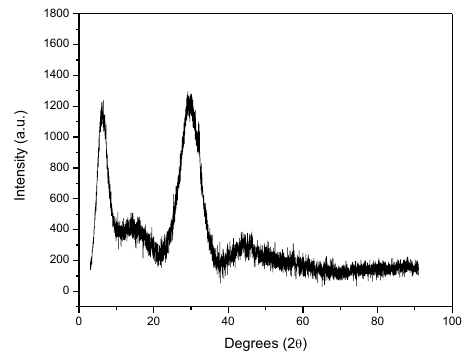
Figure 1: XRD pattern of the LaFeO3 powder sample with glucose/citric acid calcined at 400°C for 2 h.